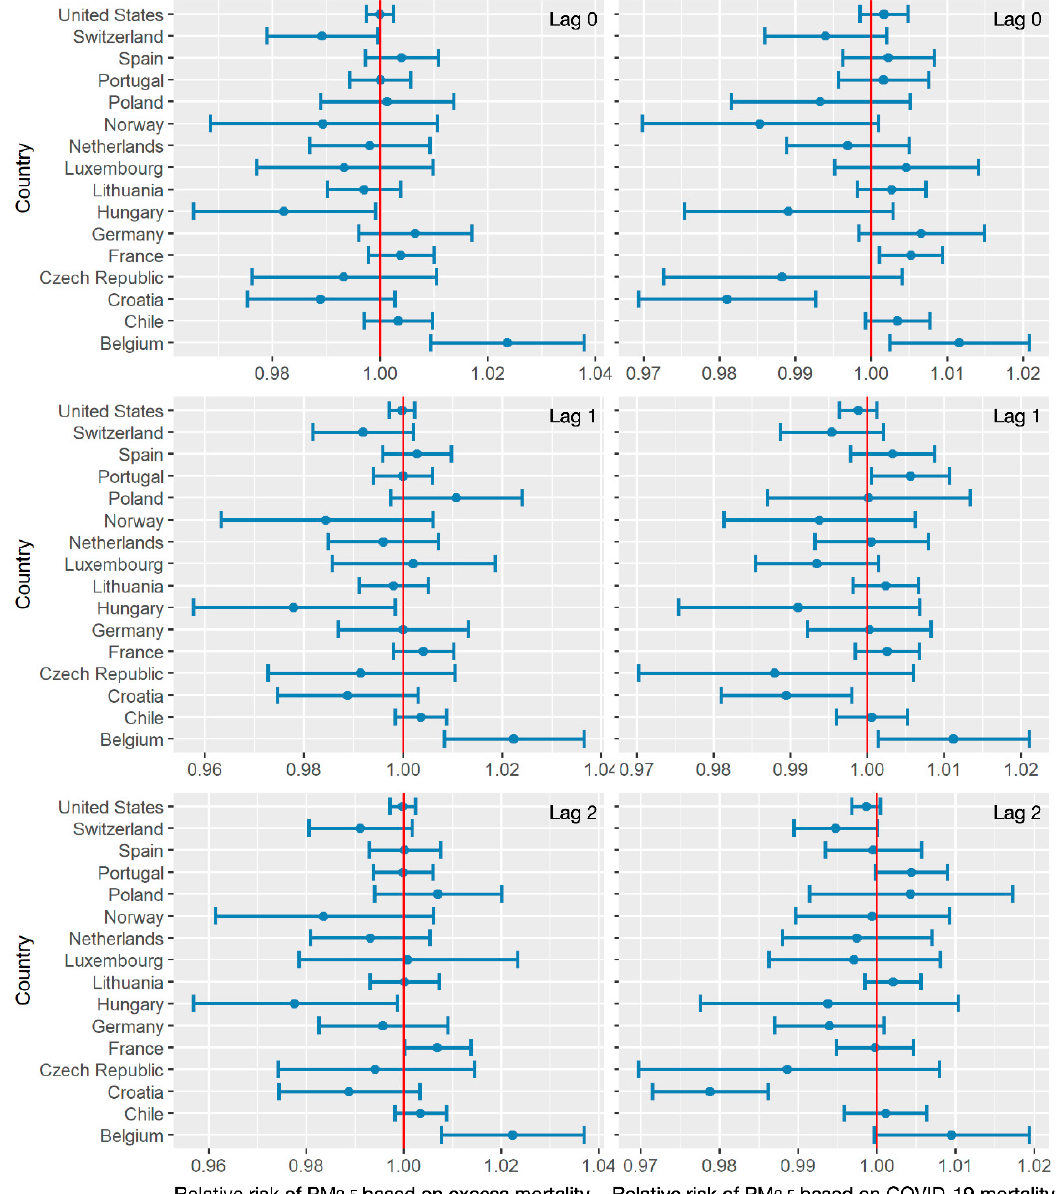
Figure 6. The relative risks of PM 2.5 related to excess mortality and COVID-19 mortality with lag effects of 0,1 and 2 weeks.